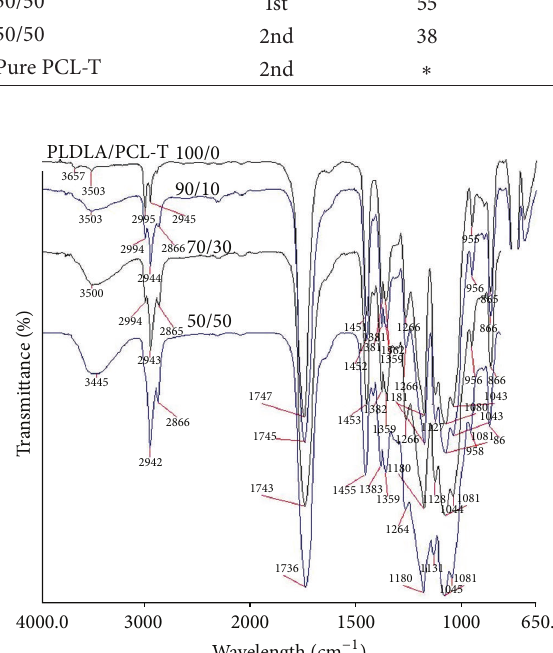
Figure 4: FTIR spectra for PLDLA/PCL-T membranes.